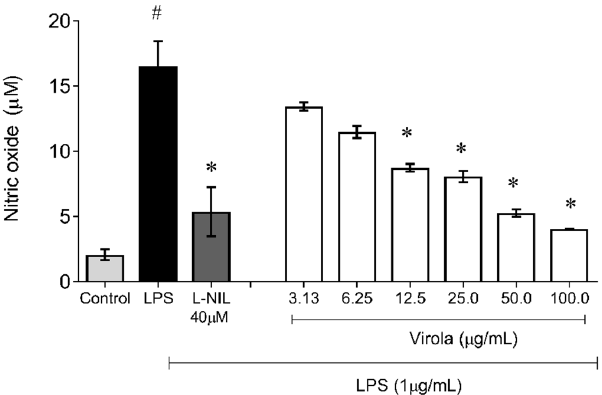
Figure 11. Lipopolysaccharide (LPS)-induced nitric oxide (NO) production showing that RV from medium dose (V12.5) until high dose (V100) inhibited NO production induced by LPS in macro- phages. L-NI: selective inhibitor of inducible nitric oxide synthase (50 μ M). The values are presented as the mean ± SEM for n = 3 cells per group. # p < 0.05 vs. control group. * p < 0.05 vs. LPS group (one-way ANOVA).